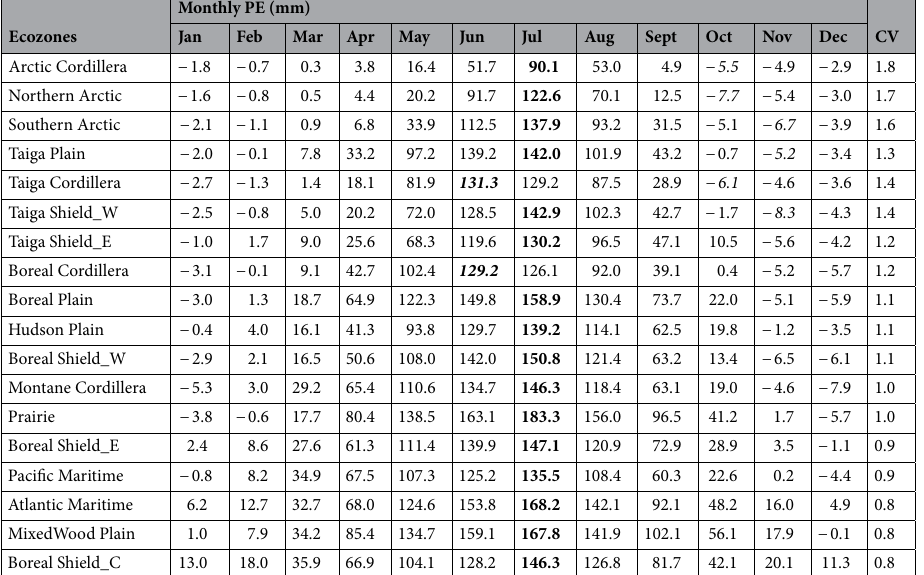
East Coast and the MixedWood Plain remains positive due to relatively high air temperature and shortwave radiation. The long-term average and CV of monthly PE indicate dramatic seasonal changes in each ecozone (Table 2). From January to July, PE across Canada gradually increases and reaches a peak in July (or June in Taiga Cordil- lera and Boreal Cordillera). The peak values vary with regions, with the largest (183 mm) in the Prairie and the smallest (90 mm) in the Arctic Cordillera. Indicated by CV, the seasonal variation in PE decreases from the Arctic Cordillera, Northern Arctic, and Southern Arctic to the Taiga Plain, Taiga Shield West, Taiga Shield West, Taiga Shield East, Taiga Cordillera, and Boreal Cordillera. The smallest seasonal variation of PE occurs in the Pacific Maritime, Atlantic Maritime, and MixedWood Plain. The Oceans and Great Lakes retain energy in warm seasons and release it in cold seasons, accounting for the small seasonal variation in PE. Long‑term trends of PE in Canada. Annual PE generally varies in a monotonic manner from 1979 to 2016, with an increasing or no trend across Canada (Fig. 7). An increasing PE trend is observed in the Northern Arctic, Atlantic Maritime, MixedWood Plain, Taiga Cordillera, Boreal Cordillera, Montane Cordillera, Pacific Maritime, Boreal Shield Coast, and Taiga Shield East. Some regions, such as the Boreal Cordillera, Taiga Shield East, and the Boreal Shield East, exhibit a turning point of no trend to an increasing trend around 1990. The increasing trends of these ecozones correspond to the elevated air temperature (Supplementary Fig. S1). How- ever, an increase in air temperature does not necessarily lead to an increase in PE in some ecozones, such as Taiga Shield West (Supplementary Fig. S1). Increasing annual PE trends are observed in the Northern Arctic, East Canada, and West Canada at a rate smaller than 4 mm/year (Fig. 8). The increasing trends are related to different climate scenarios. In the Northern Arctic, the increase of annual PE is mainly associated with the elevated air temperature (Fig. 8e) and downward longwave radiation (Fig. 8c). The increase of annual PE in West Canada is primarily related to the increased downward longwave radiation (Fig. 8c, d) and wind speed in the Pacific Maritime. The increase of annual PE in East Canada is mainly attributed to the increase in downward shortwave and longwave radiation (Fig. 8d). Elevated air temperature also plays a role in the increase of PE in some regions of East Canada, such as the Taiga Shield East (Fig. 8e). The wind speed trend is not shown in Fig. 8 because the changes are only observable in a few regions, and the change rate is meager (< 0.01 m/s/year). The annual PE trends are not statistically significant at the 95% confidence interval in the other regions of Canada, including Taiga Plain, Taiga Shield West, Hudson Plain, Boreal Shield West. The non-significant trends are related to the increased humidity (Fig. 8b), which weakens the aerodynamic component and decreases PE. The decreased PE offsets the increase in PE associated with the increased shortwave radiation and air tempera- ture (Fig. 8d, e). Increasing trends of monthly PE are observed in both warm and cold seasons (Fig. 9). In warm seasons, the Northern Arctic, East Canada, and West Canada (Fig. 9e–i) have experienced an increase in PE. Specifically, the Northern Arctic has increasing PE in July to September, corresponding to the elevated air temperature and downward longwave radiation (Supplementary Figs. S2, S4). PE in East Canada has an increasing trend in May, June, July, and September, mainly due to the increase of air temperature (Supplementary Fig. S2). West Canada